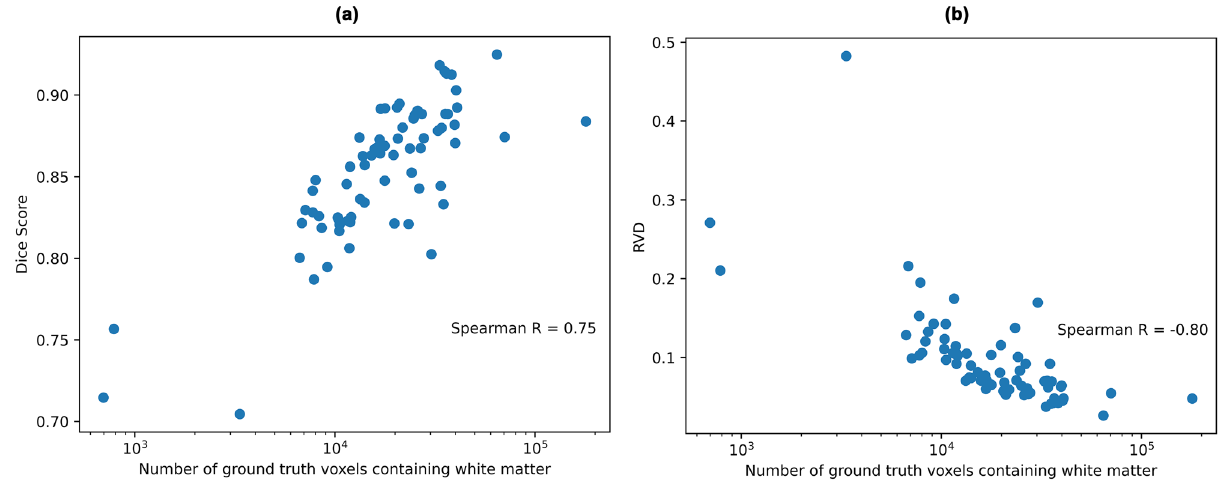
plotted on a logarithmic axis, and is measured as the number of voxels labelled as containing white matter in the ground truth segmentation mask for a given tract, averaged over all 105 subjects. Each circular marker indicates a white matter